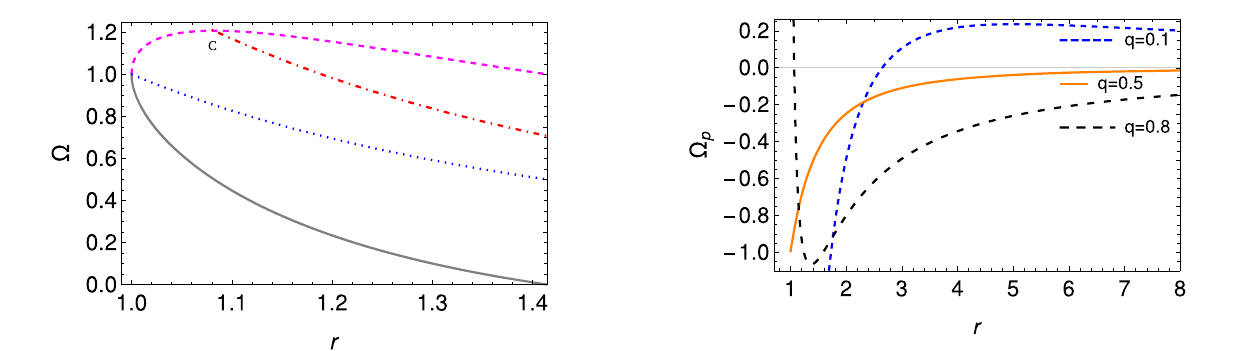
Fig. 2 Variation of (cid:3) p (unit of ‘length − 1 ’) versus r (unit of ‘length’) for A = B = 1. It shows that the spin precession frequency (cid:3) p becomes arbitrarily large as it approaches to the horizon for any value of q whereas (cid:3) p is finite for q = 0 . 5 at r → r